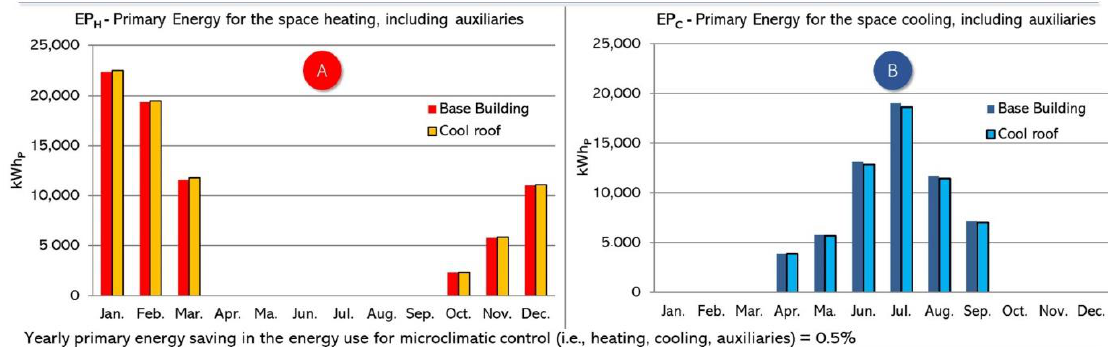
Figure 7. HVAC Heating and cooling primary energy demand, before and after the cool roof installment.